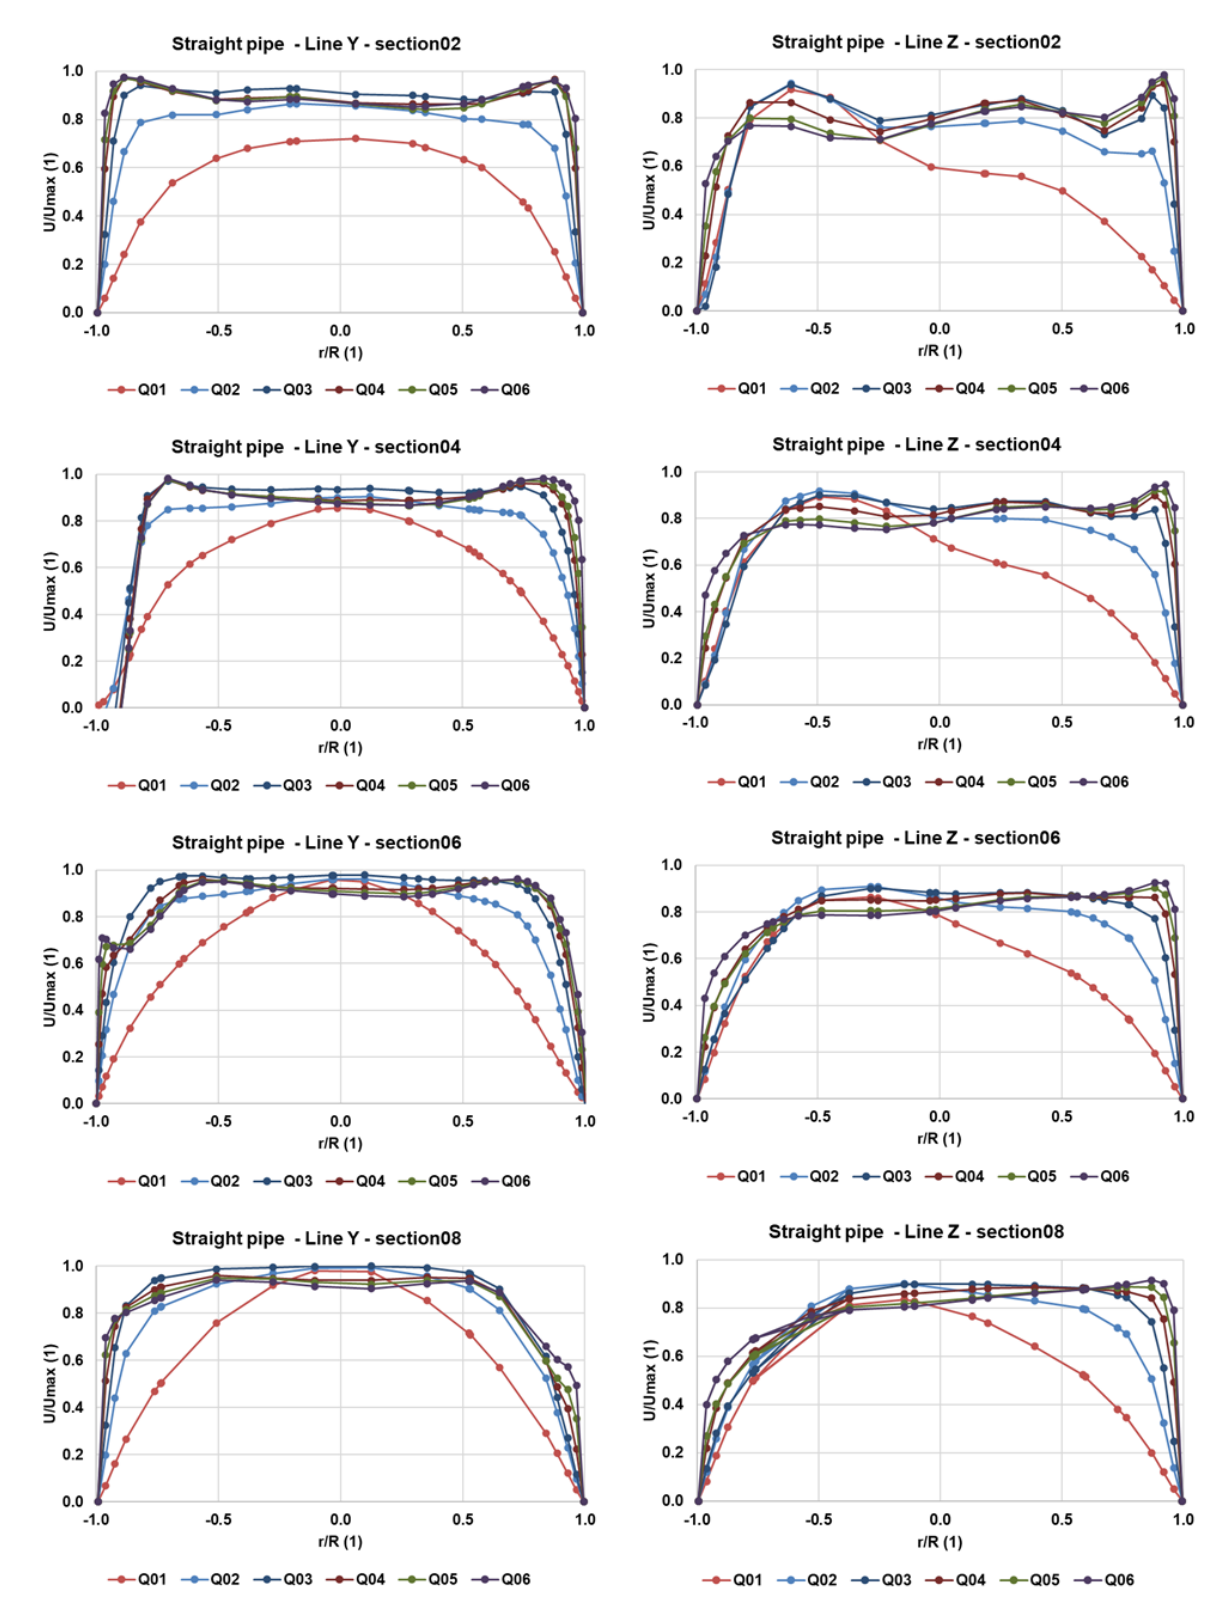
Fig. 6 Velocity profiles – straight pipe (no disturbance), selected